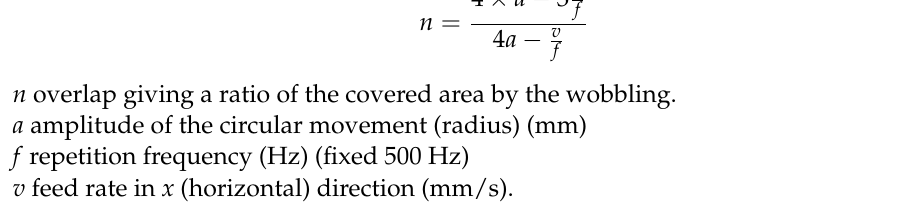
Figure 3. Selected beam trajectory for the joining process. Based on [24], the circular wobbling was optimized when the overlap (as described by Equation (2)) was 0.75. This overlap led to the feed rate of 111.1 mm/s for the laser beam in the x (horizontal) direction.